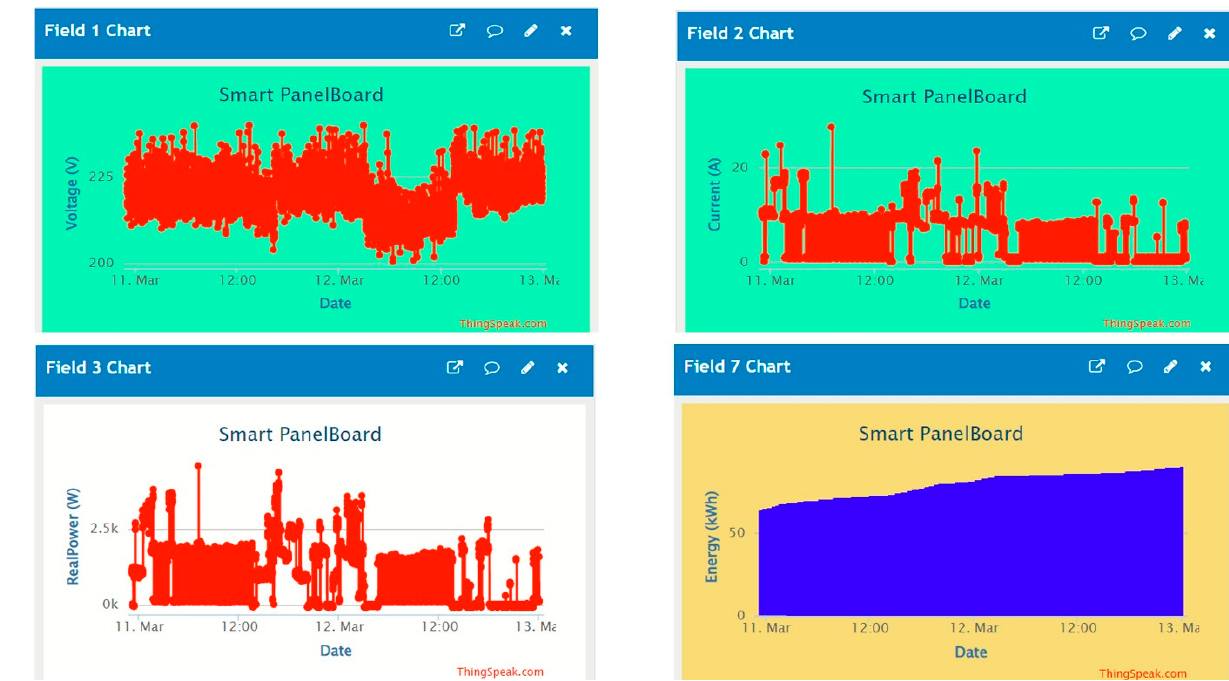
Figure 4. Measured DPB data visualized on ThingSpeak IoT platform.